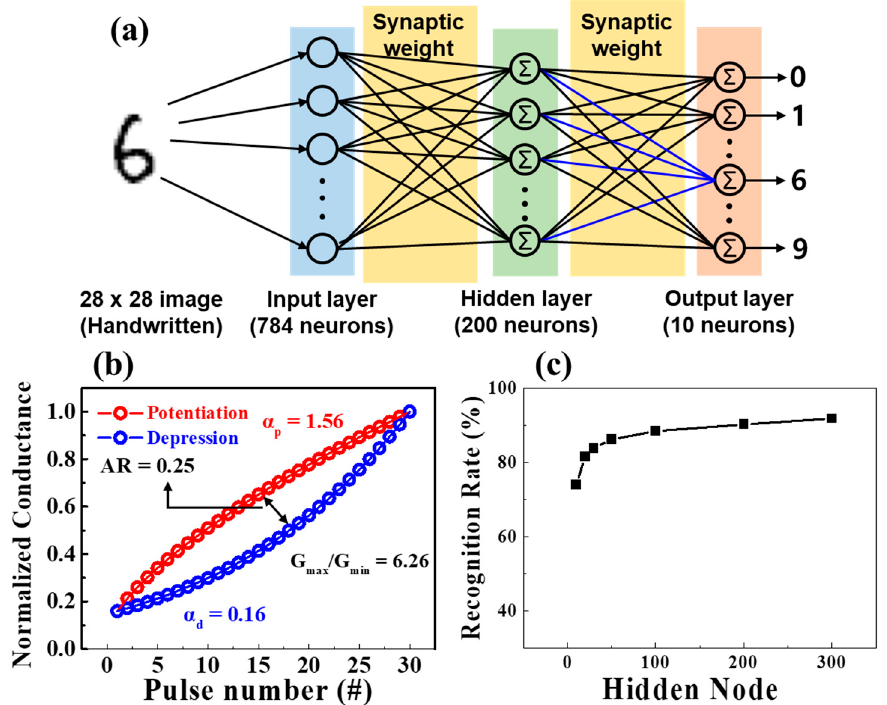
Figure 8. ( a ) Schematic diagram of a three-layer connected ANN with input, hidden, and output layers for MNIST recognition. ( b ) Nonlinearity analysis for normalized potentiation and depression ( G / G max ). ( c ) Simulated recognition rates with various numbers of hidden nodes in epoch 1.